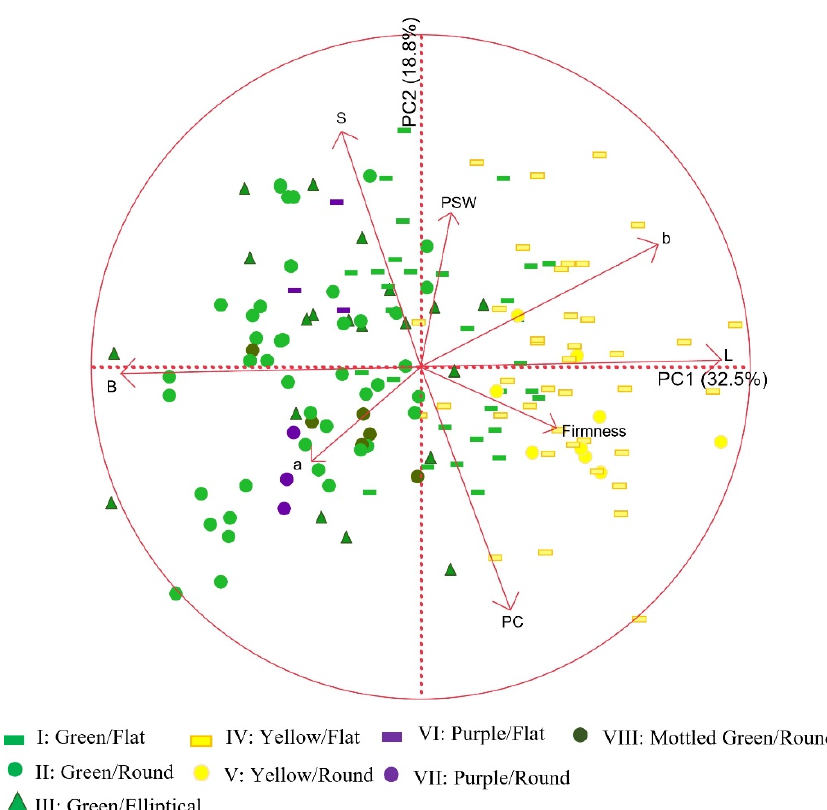
Figure 2. Principal component analysis (PCA) score plot of the entire set of SBP. Loadings are indicated by arrows, and lines are highlighted with different colors and shapes based on the different groups. Table 3. Mean values for the traits recorded in the eight pod phenotypic groups established for the set of 54 SBP